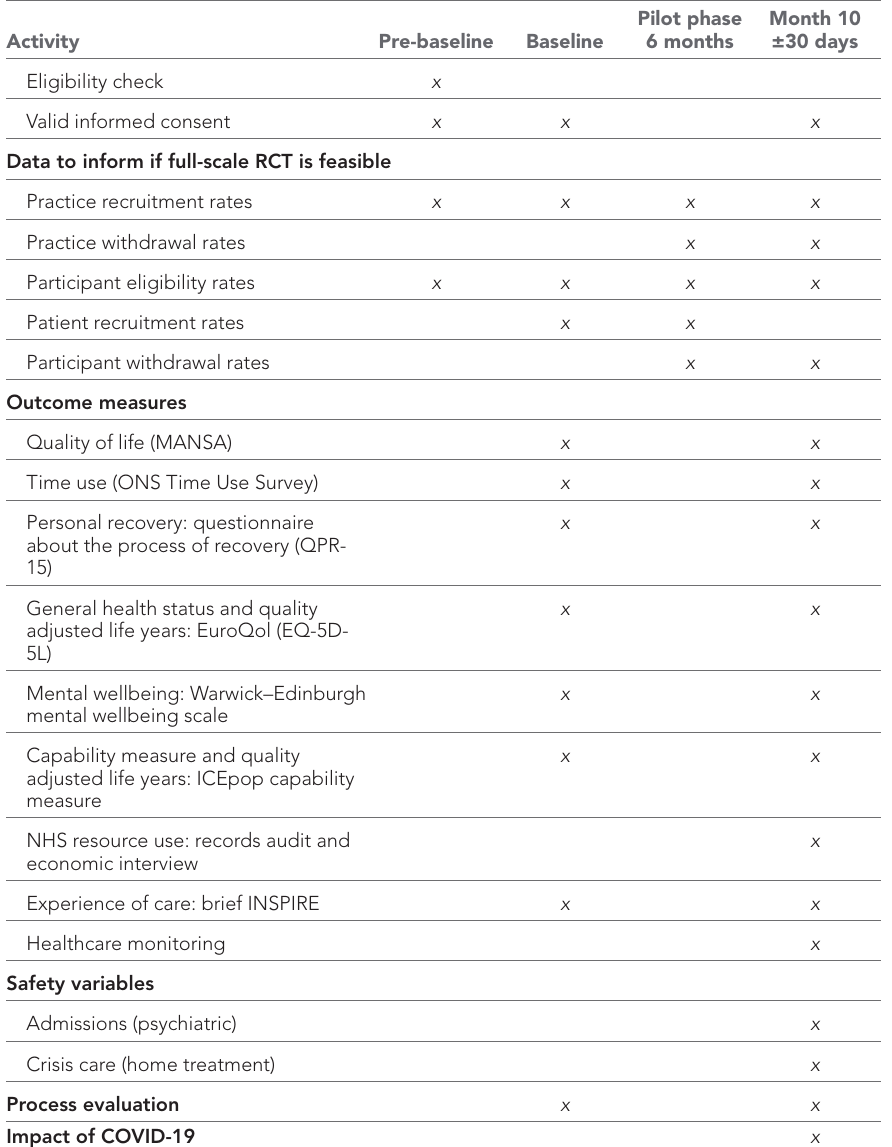
Table 4 Schedule of assessment for practices and